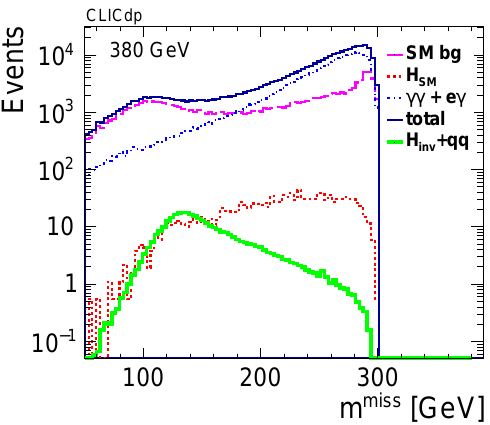
Figure 1: Distribution of the reconstructed mass of the invisible Higgs boson decay products, after preselection cuts, for different event samples: e out Higgs boson production (long-dashed pink line), background of SM Higgs boson production and decays (short-dashed red line), photon-induced interactions (dash- dotted blue line), sum of background contributions (thin solid indigo line) and signal (thick solid green line). Total integrated e 380 GeV CLIC stage. The signal sample is normalised to BR ( H → inv ) = 1%. Figure reproduced from [ 3 ]